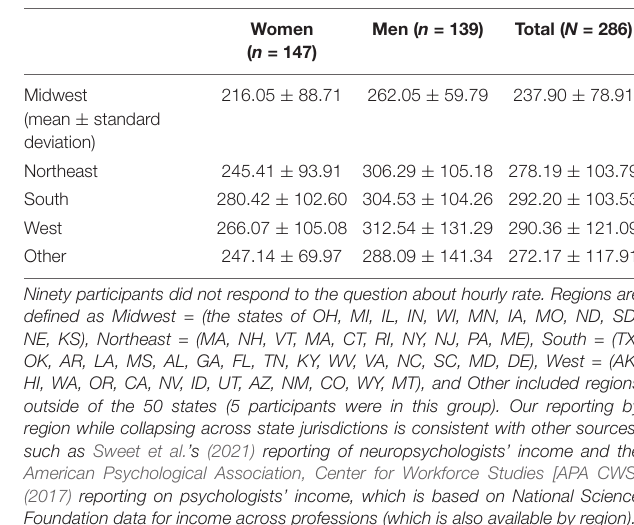
TABLE 2 | Hourly rate (USD) of forensic psychologists across U.S.